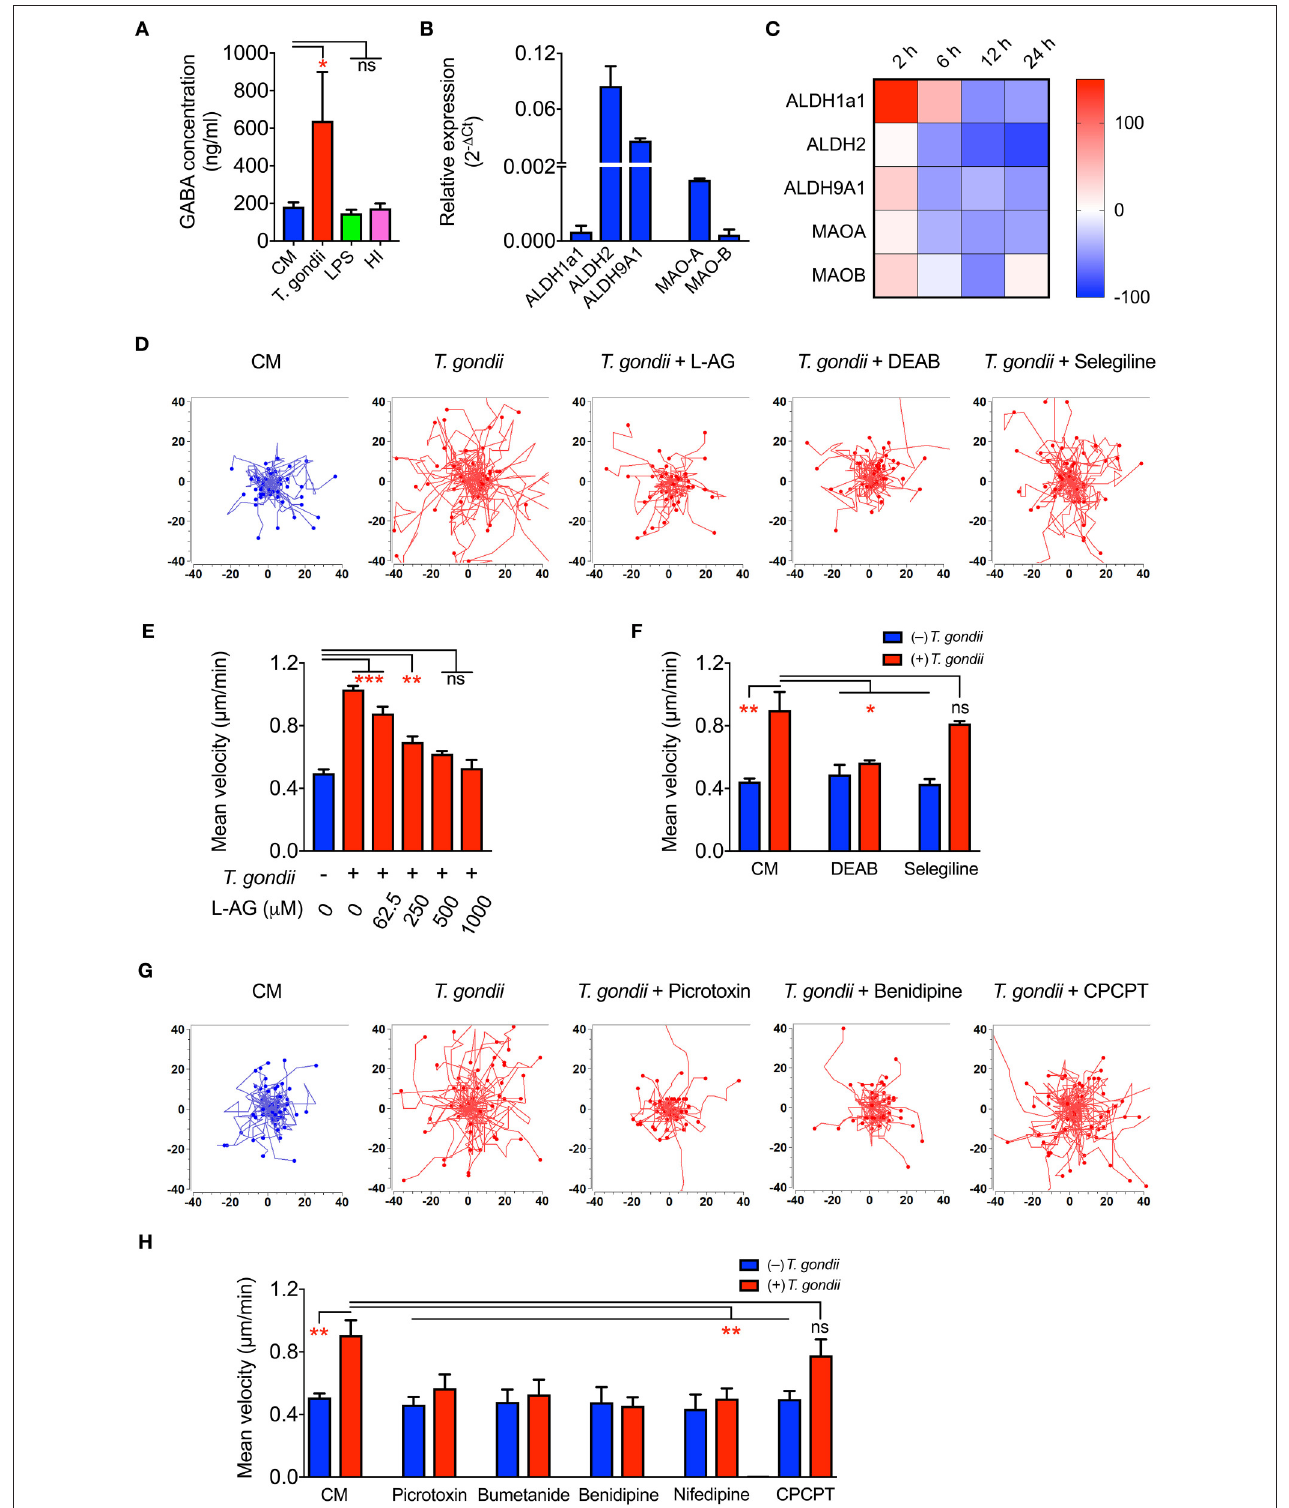
FIGURE 5 | GABA secretion and impact of GABAergic inhibitors in Toxoplasma- challenged microglia. (A) GABA concentration in the supernatants from microglia incubated with complete medium (CM), PRU tachyzoites, LPS (100ng/ml) or heat-inactivated tachyzoites (HI) was quantified by ELISA as indicated under Materials and Methods. (B) The relative mRNA expression (2 − 1 Ct ) of the enzymes -Aldehyde dehydrogenases (ALDH1a1, ALDH2, ALDH9A1) and monoamine oxidases